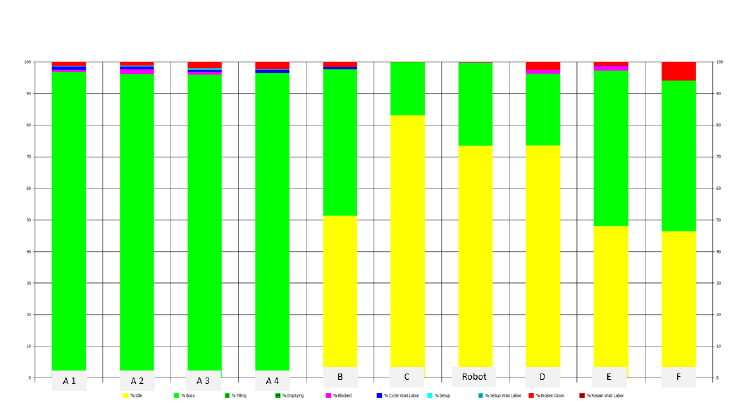
Figure 10. Example of the occupancy rate of Layout 1.